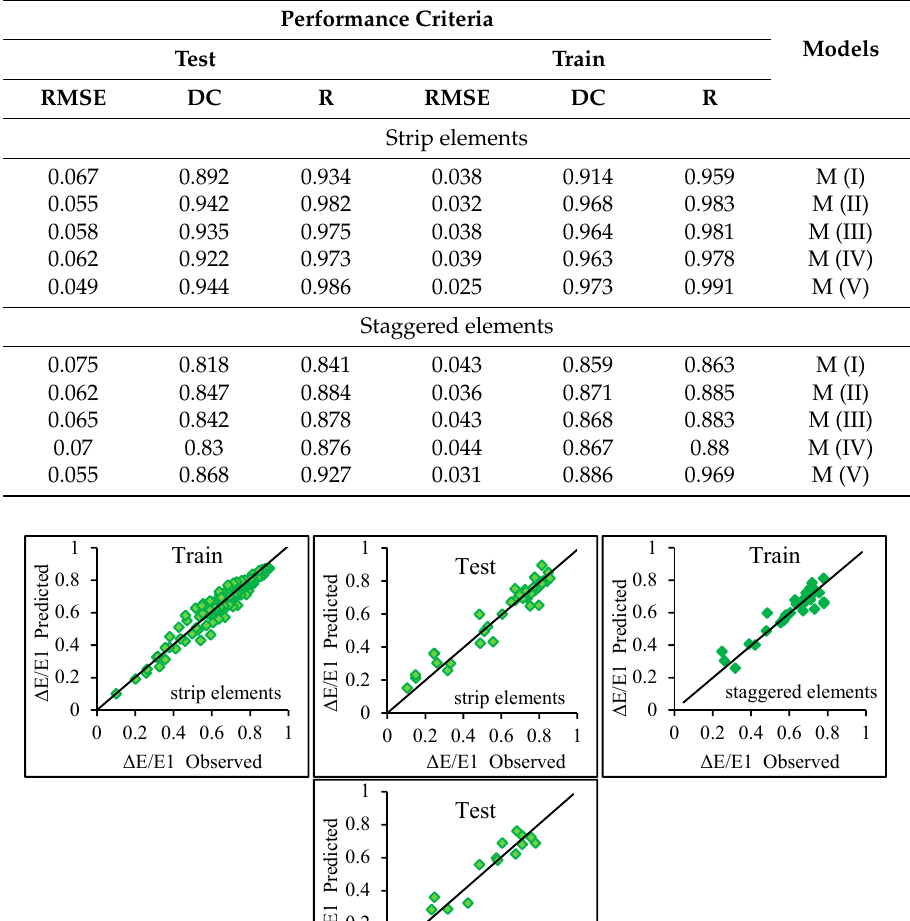
Table 3. Statistical parameters of the KELM models for the rectangular shape channels.